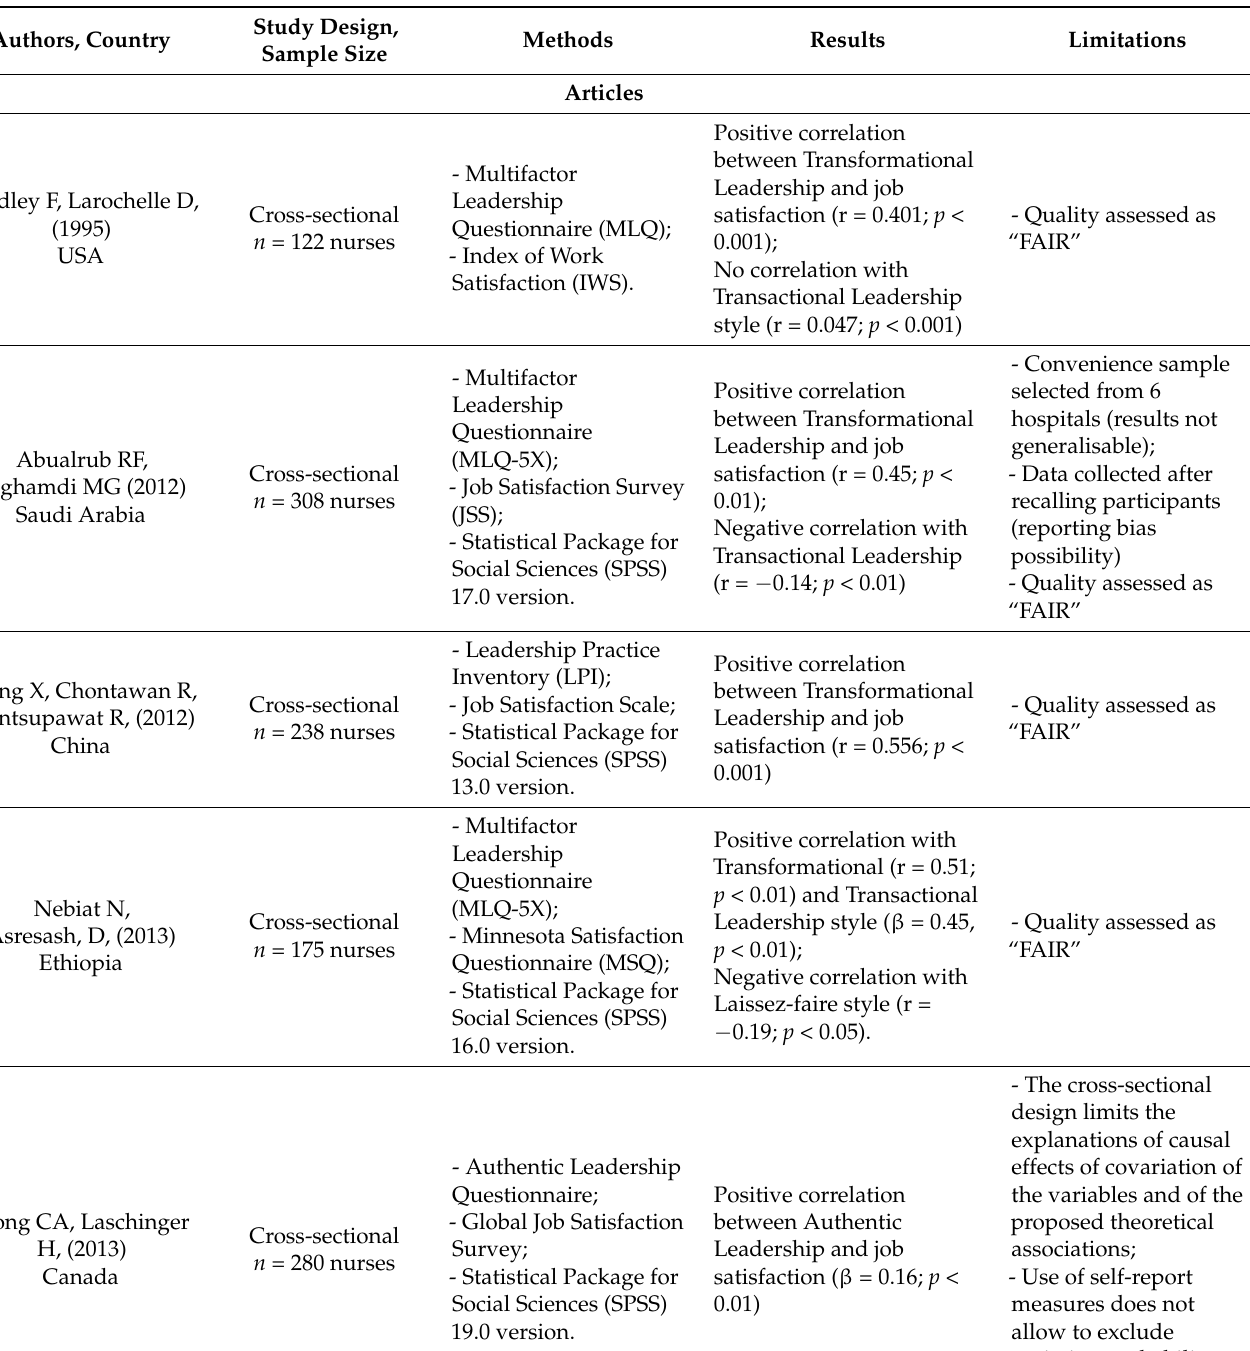
Table 2. Analysis of the studies